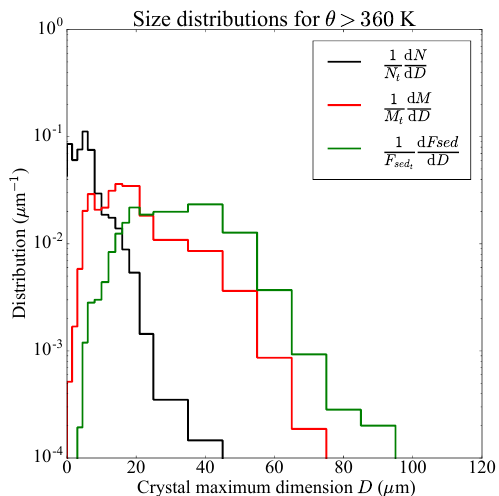
Figure 8. Average ice crystal size distribution within cirrus clouds during ATTREX 2014 flights, above θ = 360K. In black, number distribution; in red, mass distribution; in green, mass flux distri- bution. The distributions shown are composites of 2DS and FCDP measurements. The size considered is the maximum dimension, the diameter for spherical particles. It should be mentioned that the size retrieved by the FCDP is not strictly exact because the retrieval of size distribution from scattered light assumes spherical particles. The sedimentation speed needed for the mass flux computation are computed using the formula of Heymsfield and Westbrook